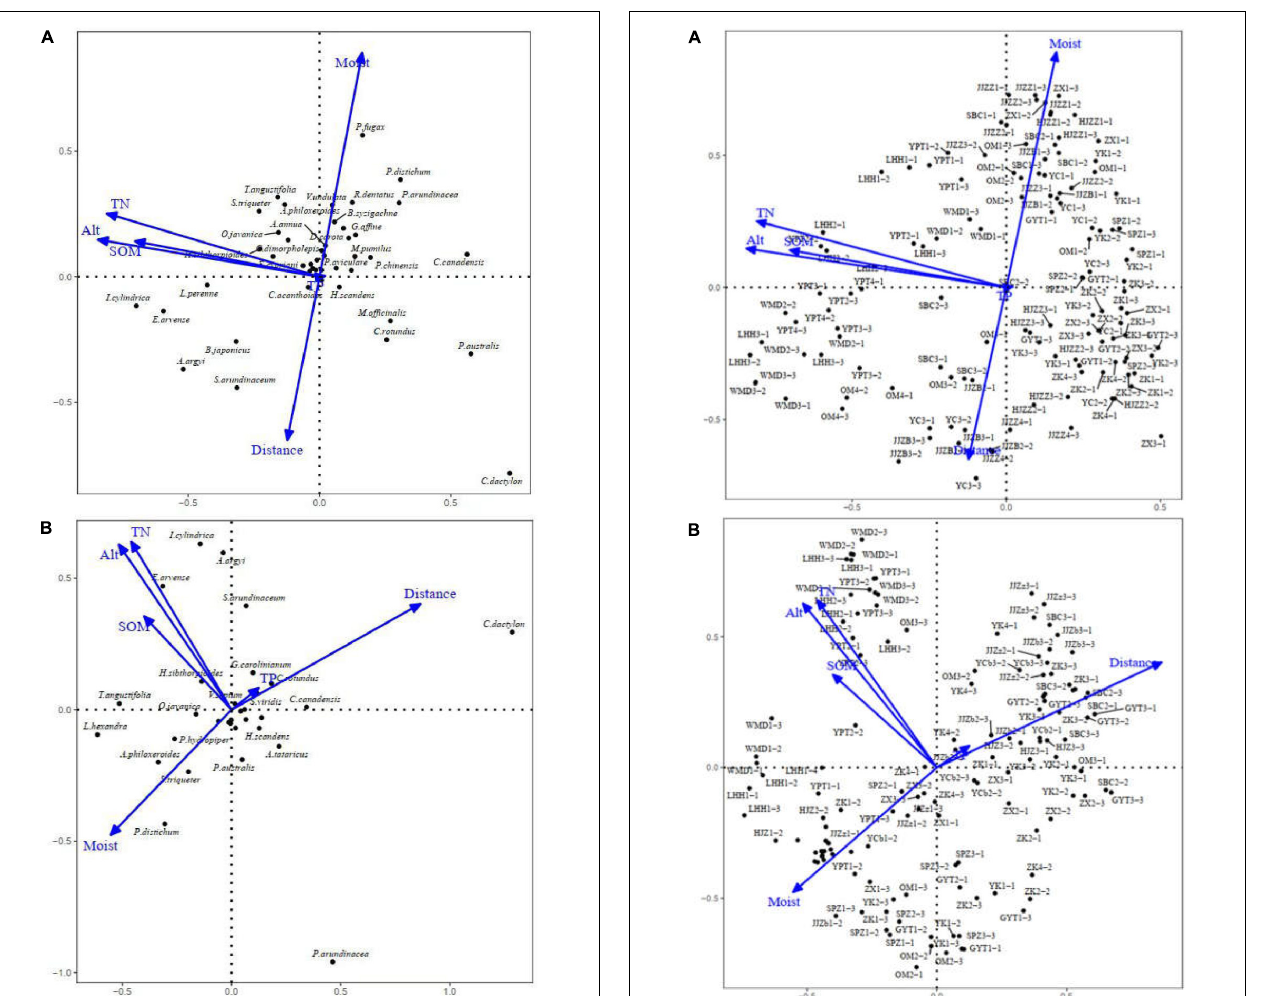
river has dropped sharply. For example, compared with before